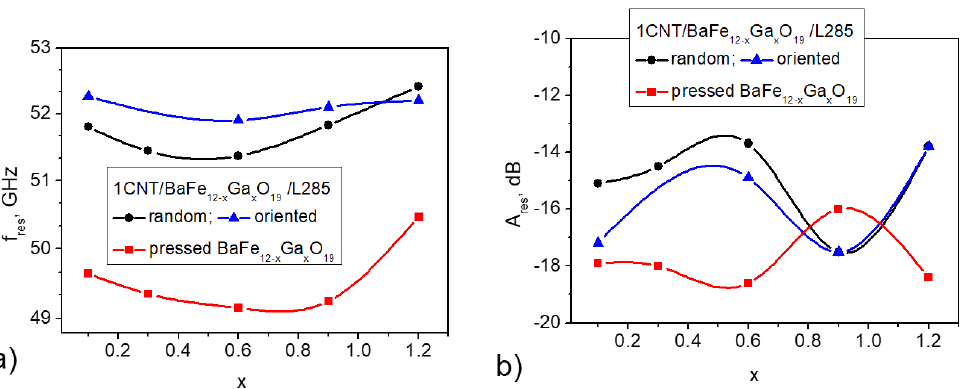
Figure 3. Concentration dependences of resonance NFMR frequency f res ( a ) and resonance NFMR amplitude A res ( b ) for epoxy composites with 1% CNT/BaFe 12- x Ga x O 19 (random and oriented filler distributions) and initial pressed sample BaFe 12 − x Ga x O 19 .